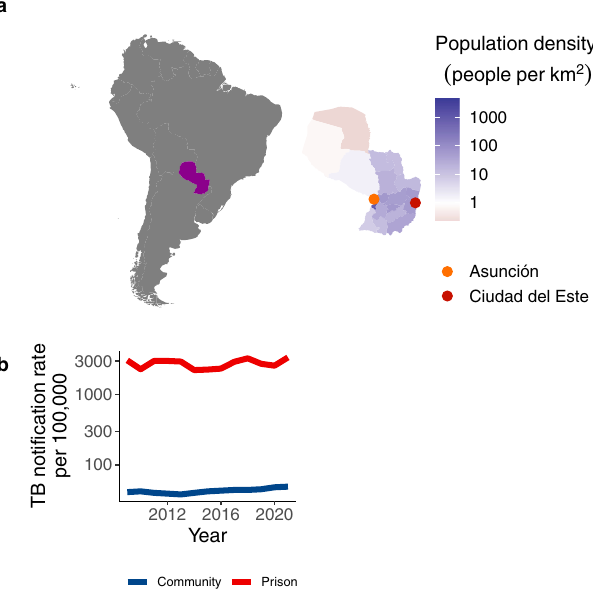
Fig. 1 | Genomic surveillance within and outside prisons in Paraguay ’ s urban centers. a Map of South America, with Paraguay highlighted, and as an inset. Paraguay ’ sdepartmentsare colored bypopulation sizedensityand pointsindicate the two largest urban centers in Paraguay, where we conducted focused genomic surveillance. b Noti fi cation rate of TB per 100,000 people in prisons (red) and in the general population (blue) from 2009 to 2020. Source data are provided as a Source Data fi